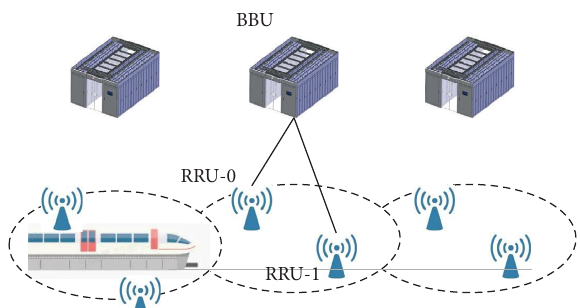
Figure 5: Modeling of high-speed railway communication